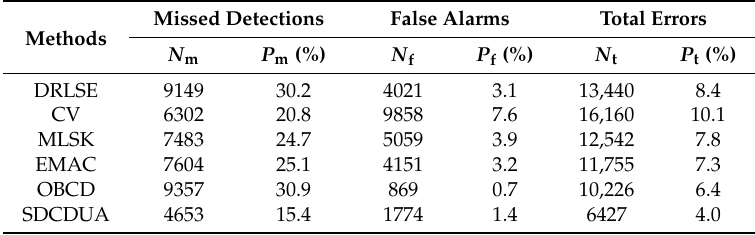
Table 3. Quantitative comparison between the comparative and proposed methods for data set